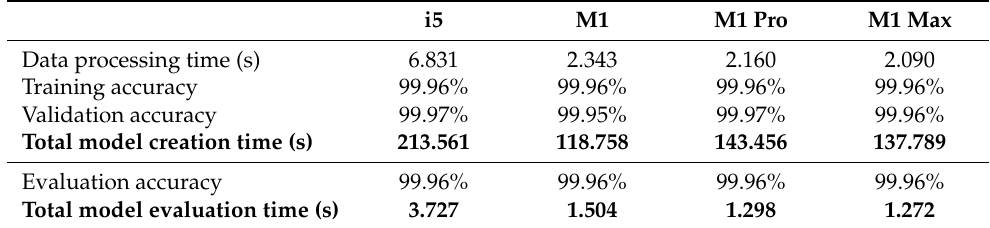
Table 9. Average test results for the ‘PaymentFraud’ dataset.